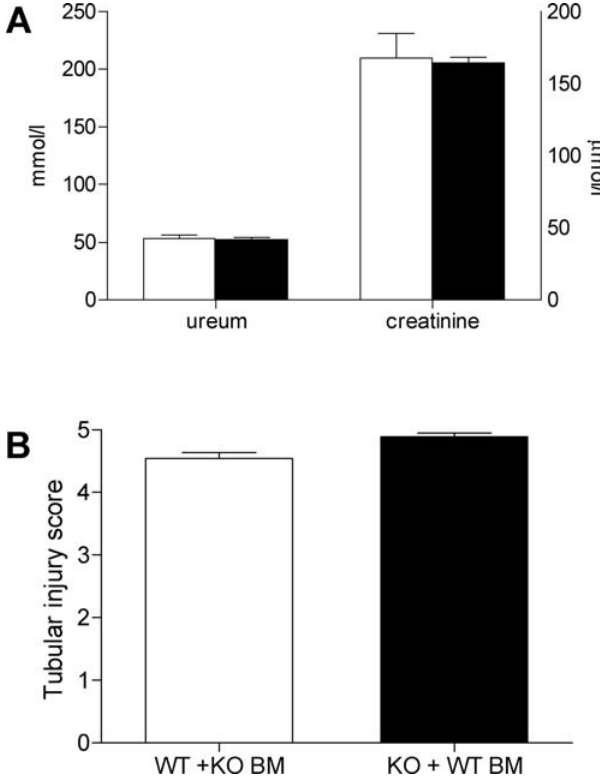
Figure 6. Equal contribution of epithelium-associated and leukocyte-associated TLR4 on renal function and injury one day after I/R injury. Renal function and injury of wild type mice reconstituted with TLR4 2 / 2 bone marrow (WT + KO BM, white bars, n=7) was comparable to TLR4 2 / 2 mice reconstituted with wild type bone marrow (KO + WT BM, black bars, n=9) one day after renal I/R injury, as reflected by equal levels of ureum (A left) and creatinine (A right) and tubular injury (B). Data are mean 6 SEM. * p , 0.05.